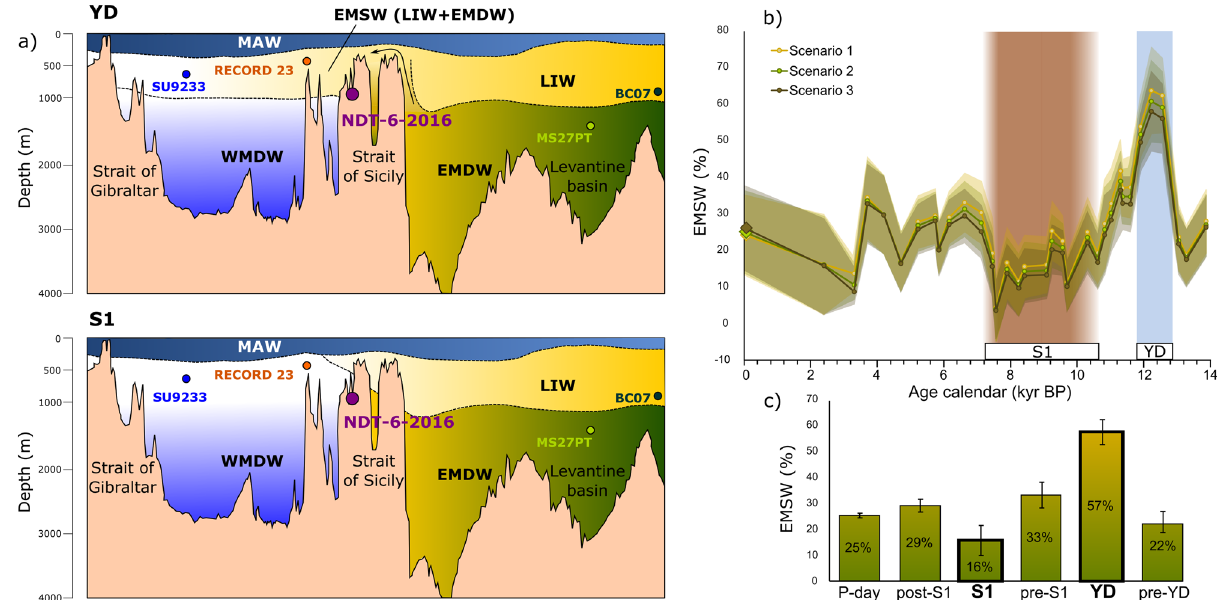
Fig. 3 Water-masses distribution in the Mediterranean Sea. a Distribution of intermediate and deep water masses in the Mediterranean Sea during both the YD and S1 and the location of the main cores discussed in this work. b Percentages of Eastern Mediterranean Source Water (EMSW) expressed as % contribution. Different scenarios corresponded with different proportions of EMDW and LIW; the fi rst scenario characterized by the same contribution of each water mass, the second one considers a LIW contribution that doubles that of EMDW and the third one takes into account a double contribution of the EMDW with respect to the LIW (yellow, light-green and dark-green lines, respectively). Shading represents the range of uncertainty in the reconstruction (95%), based on analytical errors. Grey-blue bar represents the YD and light-brown bar the S1. Current percentages of EMSW are calculated using present-day seawater ε Nd values from WMDW, LIW, EMDW 47 and South Tyrrhenian Sea 49 and are indicated with rhombs (see supplementary Table 3). c Average values of EMSW export in the studied location for each period discussed in this work. Error bars re fl ect the uncertainties associated to the average values calculated for each period (YD, n = 9; pre-YD, n = 9; post-YD, n = 15; S1, n = 33; 2sd). Error bar for present- day values correspond to the uncertainty in the reconstruction (95%), based on analytical